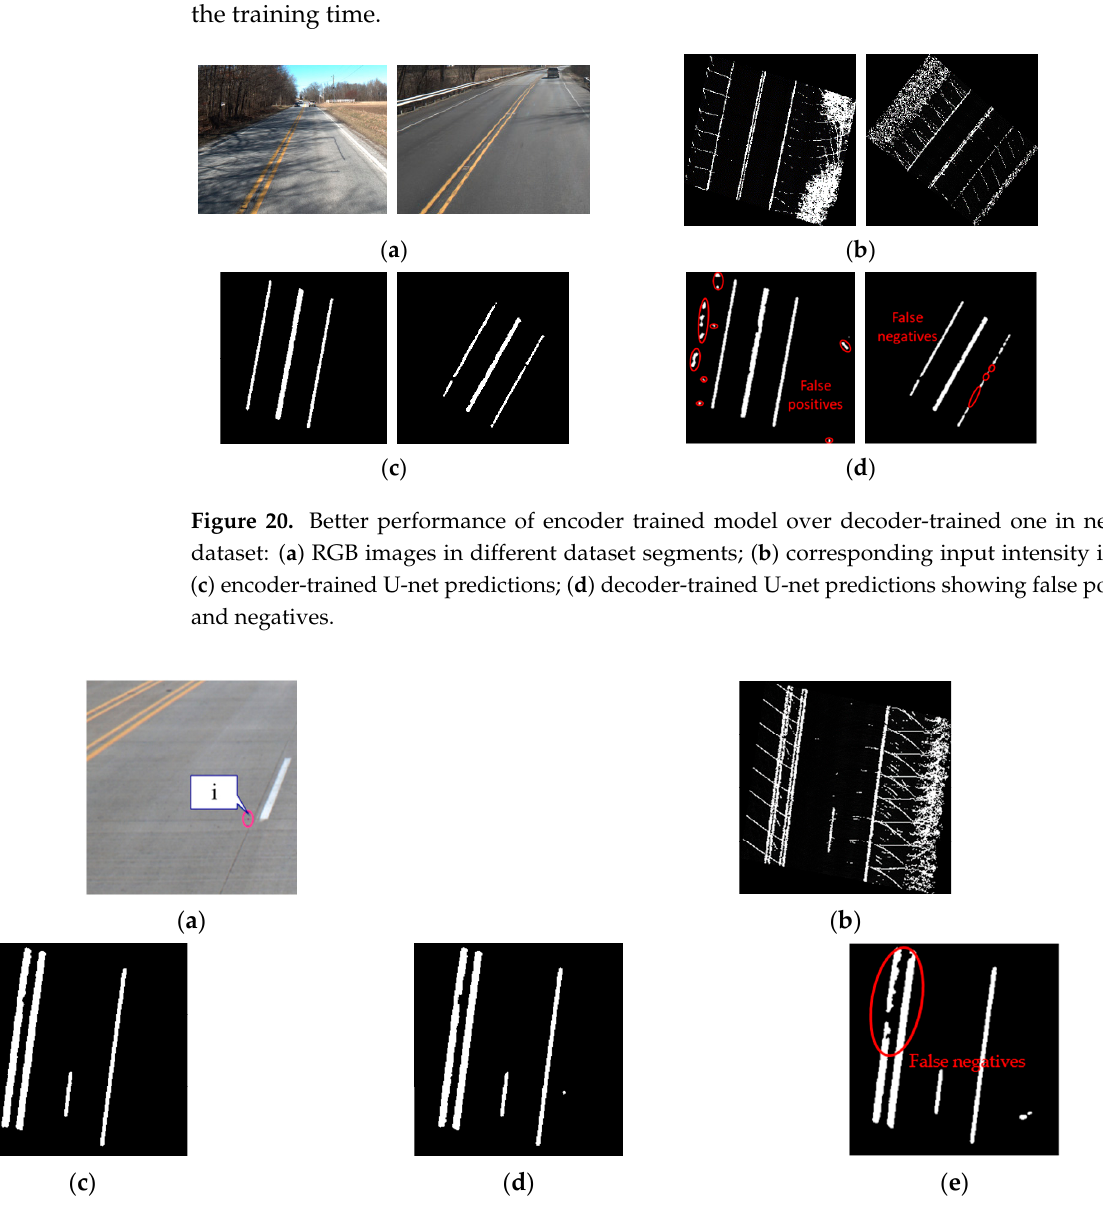
Figure 21. Better performance of fine-tuned models over one trained from scratch on new test dataset: ( a ) RGB image for location i (same location i as in Figure 17); ( b ) corresponding intensity image; ( c ) encoder-trained U-net predictions; ( d ) decoder-trained U-net predictions; ( e ) predictions by the U-net trained from scratch showing false negatives.